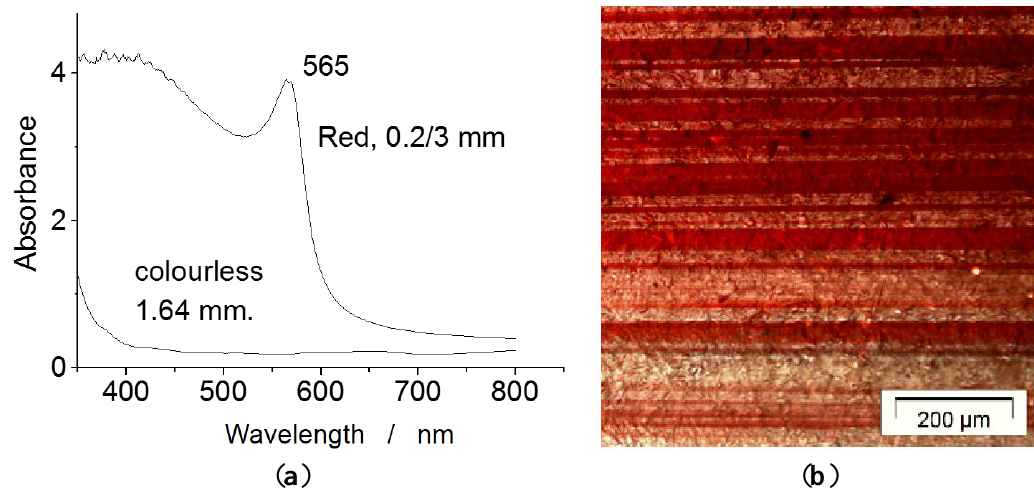
Figure 7. ( a ) UV-visible absorbance curve of a 19 th century typical glass, free from or with a 200 µm thick Cu°-containing layer exhibiting a plasmon peak; ( b ) optical micrograph of a Middle-Age red flashed glass showing alternate colored and non-colored glass. This example shows the sophistication of the ancient technology (after